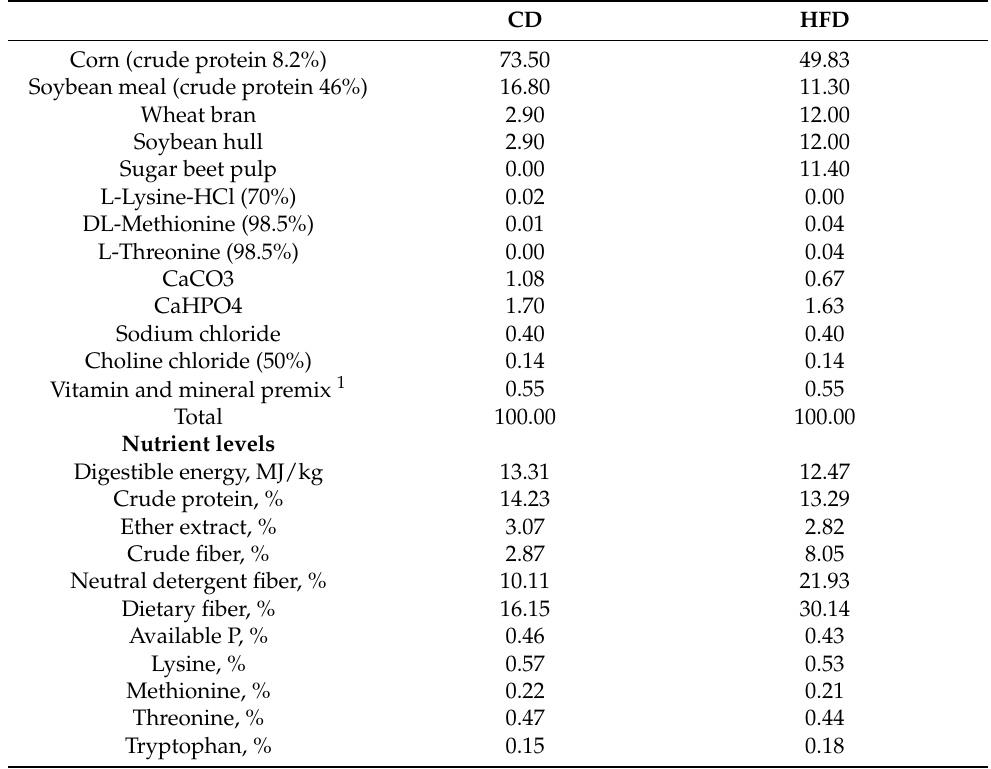
Table 1. Ingredients and nutrient levels of experimental